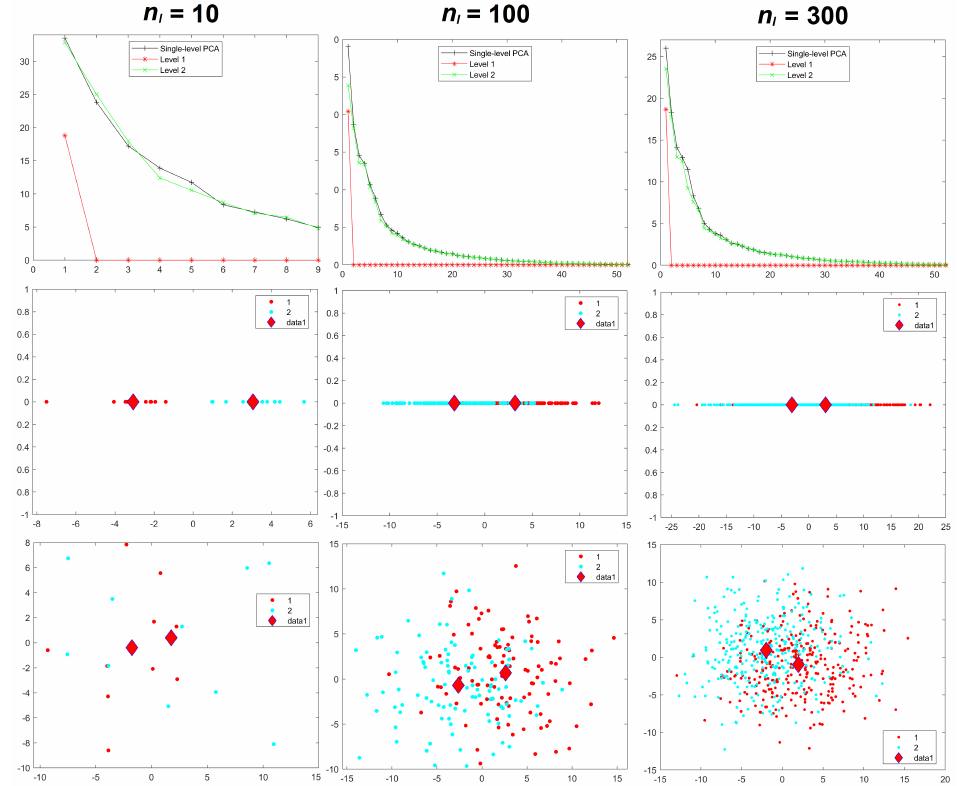
Figure 9. Experiment 5: eigenvalues ( upper row ), mPCA, level 1 component scores ( middle row ), and single-level PCA, component scores ( bottom row ) for sample sizes per group of n l = 10 ( left-hand column ), n l = 100 ( middle column ), and n l = 300 ( right-hand column ) in both groups l = 1,2. Group centroids are shown by the diamonds; x -axis = first component; y -axis = second component.